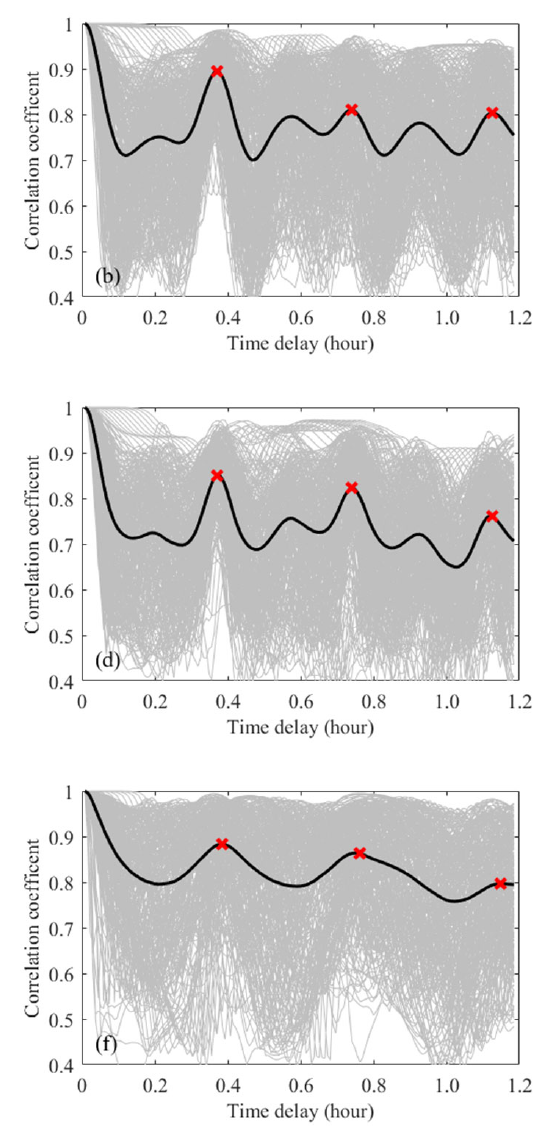
Figure 8. Simulated correlation coefficients at the range of 14.8 km in the ideal ISWs environment at three different depths: ( a , b ) 12 m, ( c , d ) 31 m, and ( e , f ) 92 m. The left three panels show contour plots of correlation coefficients vs. the time and time delay, and the rectangles mark the strongly correlated zones. The right three panels show curves of correlation coefficients vs. the time delay at different times. The bold curve is the time-averaged correlation coefficients, and the “x” symbols mark the inflection points.